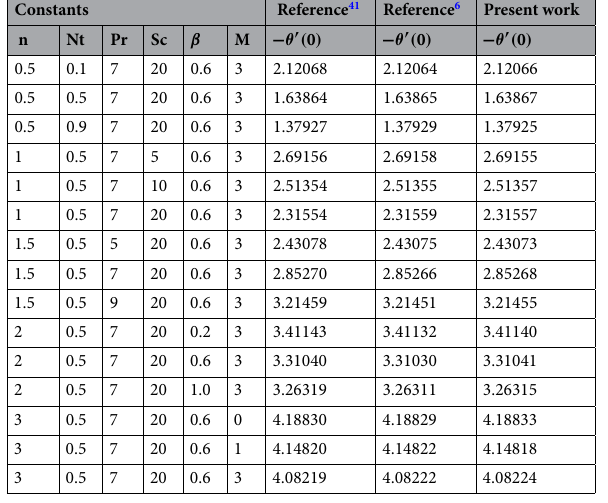
Table 1. Comparison of the present result with previous published work, when Ec = f w = (cid:31) = 0 and for present work ϕ = K = R = Gr = Gc = 0 .